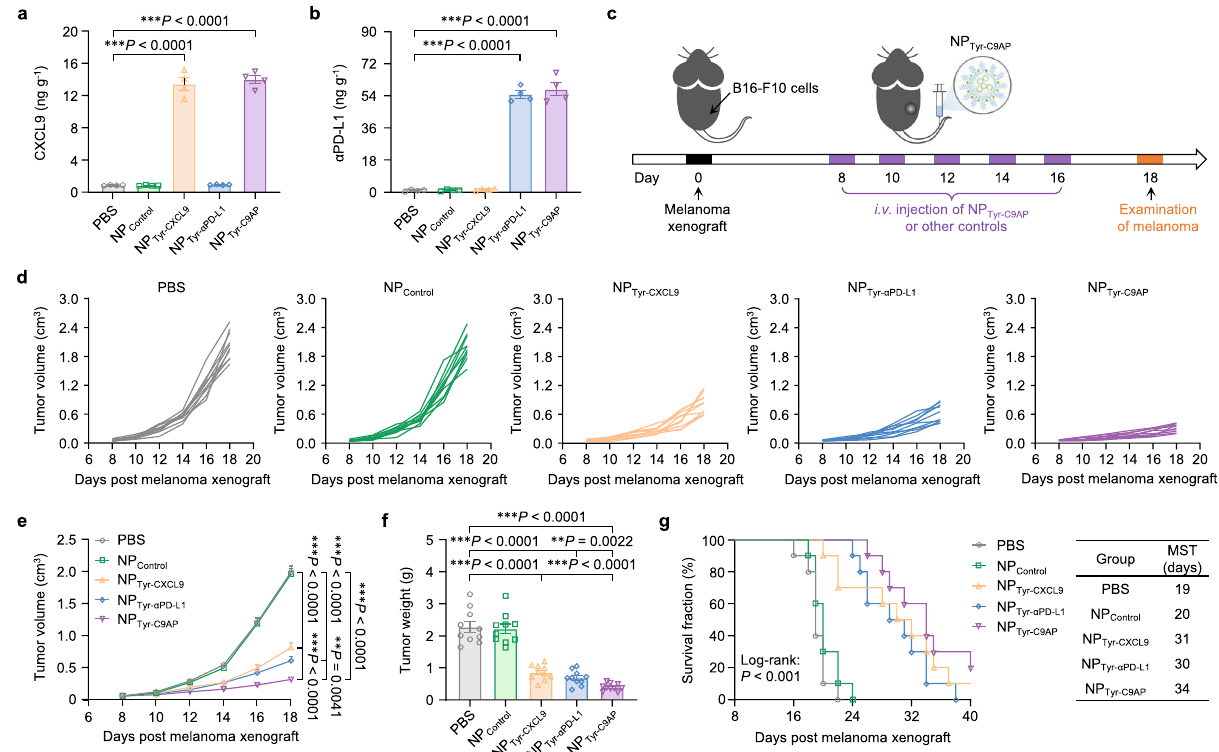
Fig. 4 | NP Tyr-C9AP induces enhanced therapeutic ef fi cacy against B16-F10 mel- anoma.a , b ConcentrationsofCXCL9( a )and α PD-L1( b )inB16-F10melanomaafter the i.v . injection of NP Tyr-C9AP or other controls ( n =4 mice per group). c Therapeutic scheme. Mice bearing B16-F10 melanoma were treated by fi ve i.v . injections of NP Tyr-C9AP or other controls. d , e Individual ( d ) and average ( e ) tumor growth curves of the B16-F10 melanoma-bearing mice treated with NP Tyr-C9AP or other controls ( n =10 mice per group). f Final tumor weights of the B16-F10 mel- anoma-bearingmiceafterthetreatments( n =10micepergroup). g